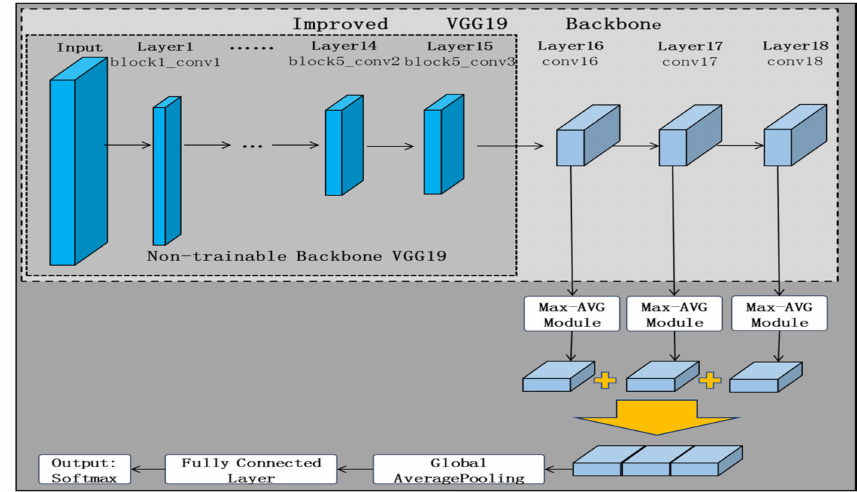
Figure 14. Improved VGG19 with feature extraction